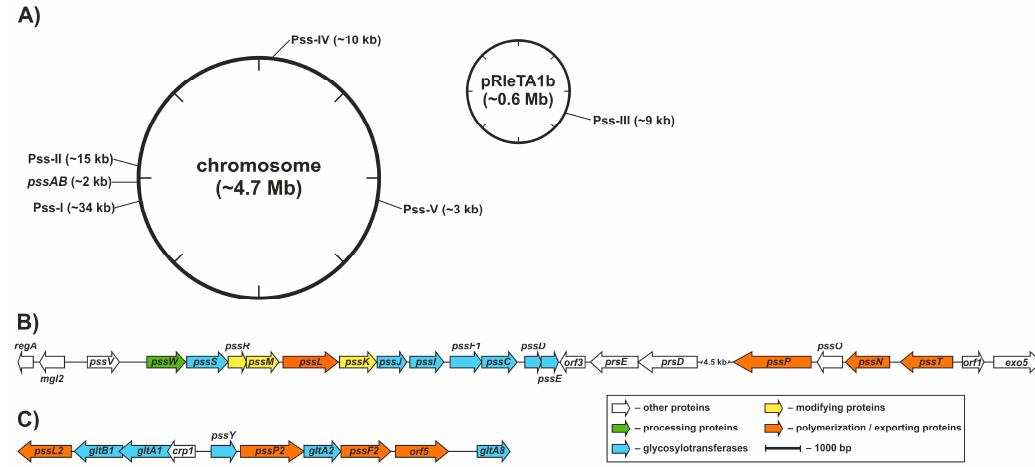
Figure 2. Genomic localization and genetic organization of the identified Pss regions in Rhizobium leguminosarum bv. trifolii TA1. Pss-I, Pss-II regions and pssAB genes are linked in the 200-kb region in